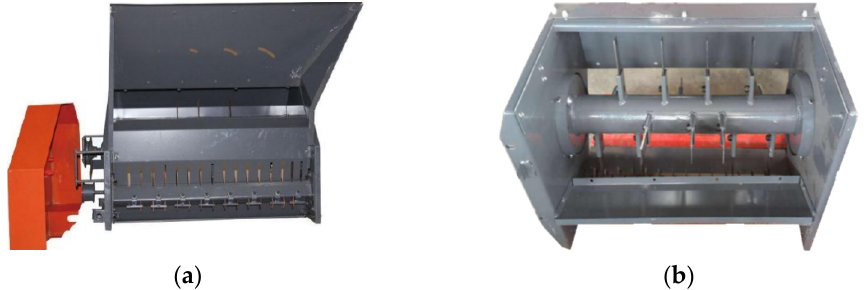
Figure 14. Straw smashing and scattering device of Kubota harvester. ( a ) Straw deflector; ( b ) straw smashing roller.